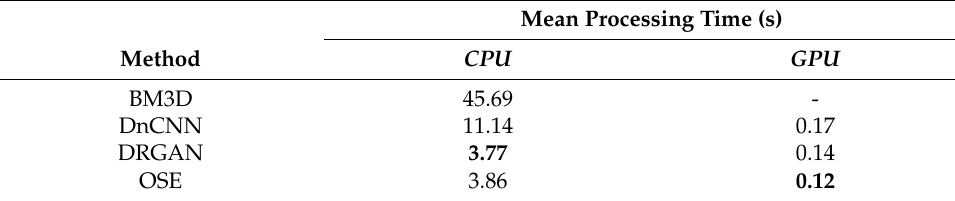
Table 3. Mean processing time for 10,000 × 1024 pixel OCT